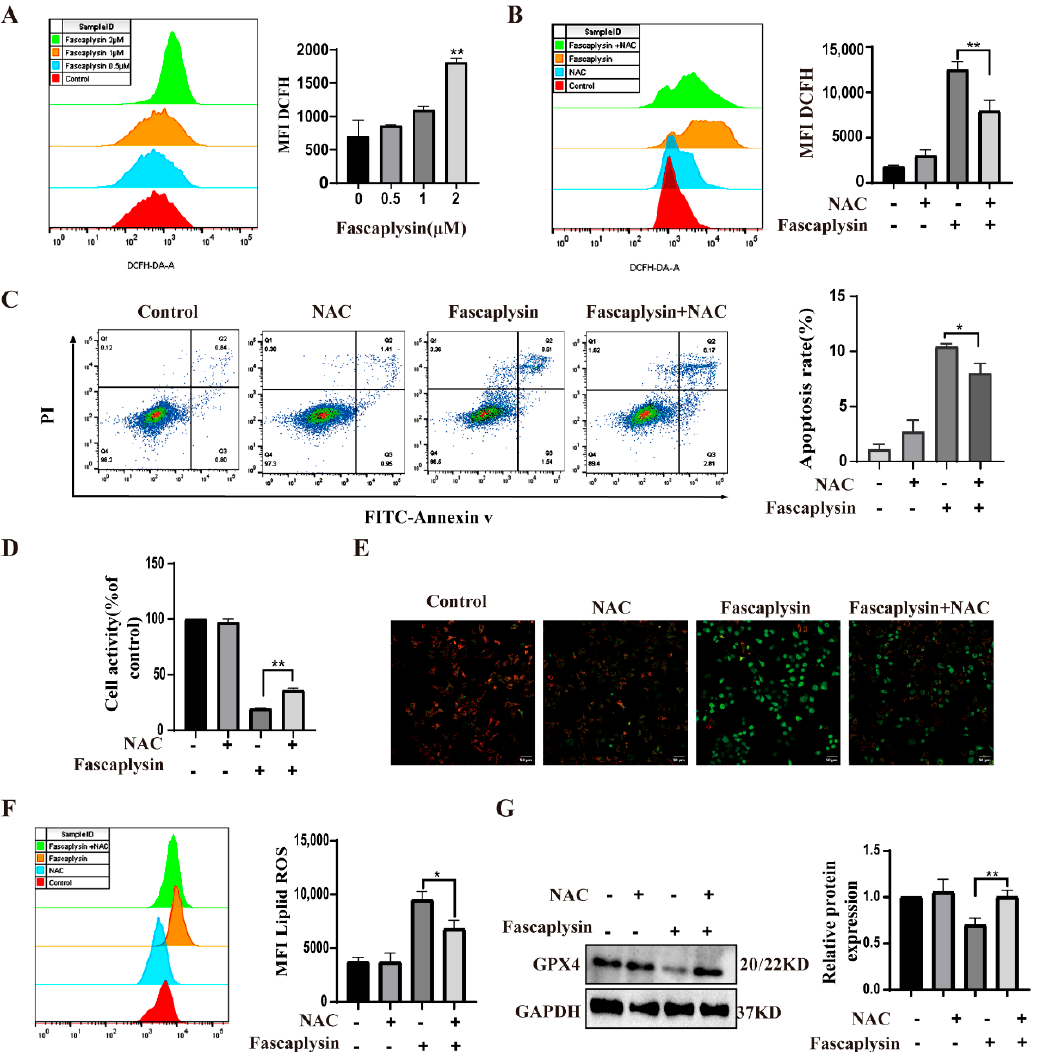
Figure 5. ROS played an important role in fascaplysin-induced apoptosis in A549 cells. ( A ) ROS in A549 cells was detected by flow cytometry with DCFH − DA probe. ( B ) ROS was detected by flow cytometry after treatment of A549 cells with the NAC (1 mM) and fascaplysin (2 µ M), alone or in combination, for 3 h. ( C ) A549 cells were treated with NAC and fascaplysin, alone or in combination, and then apoptosis was detected by flow cytometry after double staining with annexin V-FITC/PI. ( D ) Cell viability was measured by CCK-8. ( E ) MMP changes were analyzed with a JC-1 probe. ( F ) A549 cells were treated with fascaplysin and NAC, alone or in combination, and lipid ROS levels were measured with a C11 BODIPY probe. ( G ) A549 cells were treated with fascaplysin and NAC, alone or in combination, and GPX4 protein expression levels were detected by Western blotting. Analysis results represent mean ± SD, * p < 0.05, ** p <